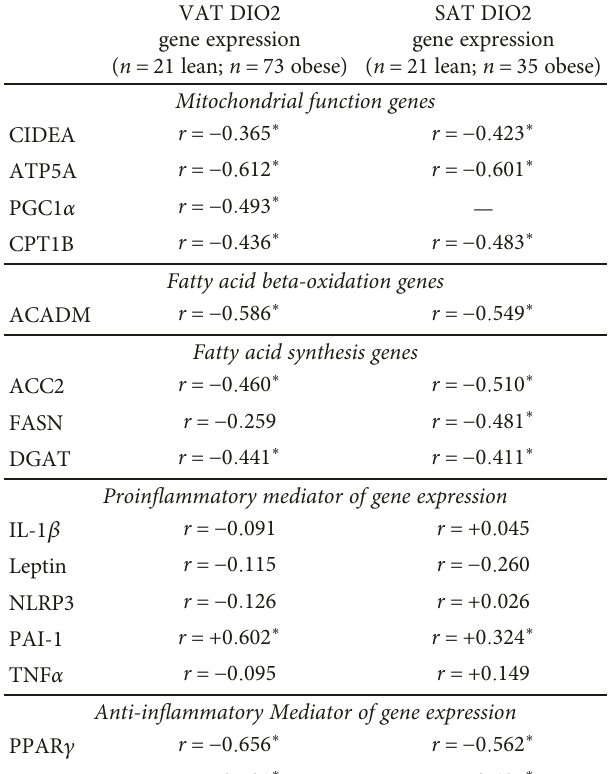
Table 2: Correlation coe ffi cients ( r ) between adipocyte DIO2 gene expression (fold change) in visceral (VAT) and subcutaneous (SAT) adipose tissue and gene expression of markers of mitochondrial function, fatty acid oxidation/synthesis, and pro- and anti-in fl ammatory genes. VAT